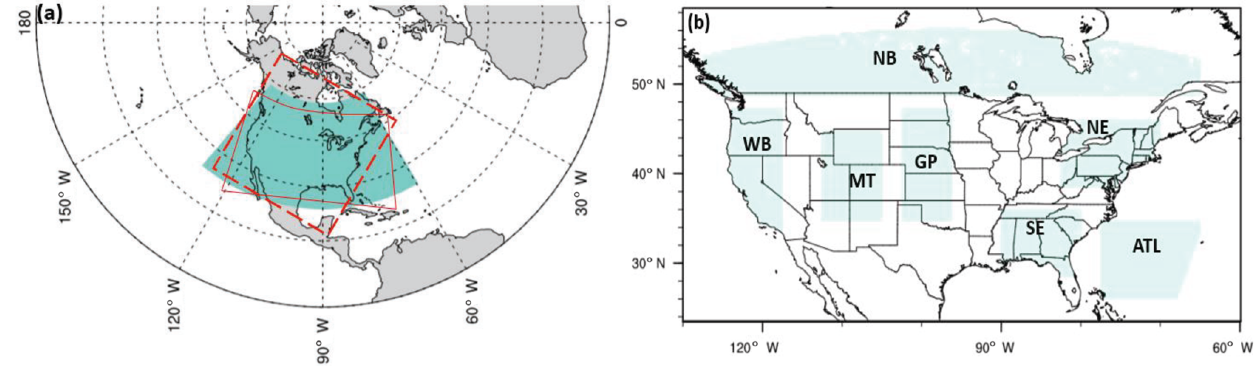
Figure 1. (a) Simulation domain for WRF / CMAQ and WRF / CAMx (red solid line), the simulation domain for WRF / DEHM (red dashed line), and the analysis domain in this study (shaded area in green). The simulation domain of COSMO-CLM / CMAQ is the same size as WRF / CMAQ but shifts westward by 48km. (b) The subregions in the analysis domain.